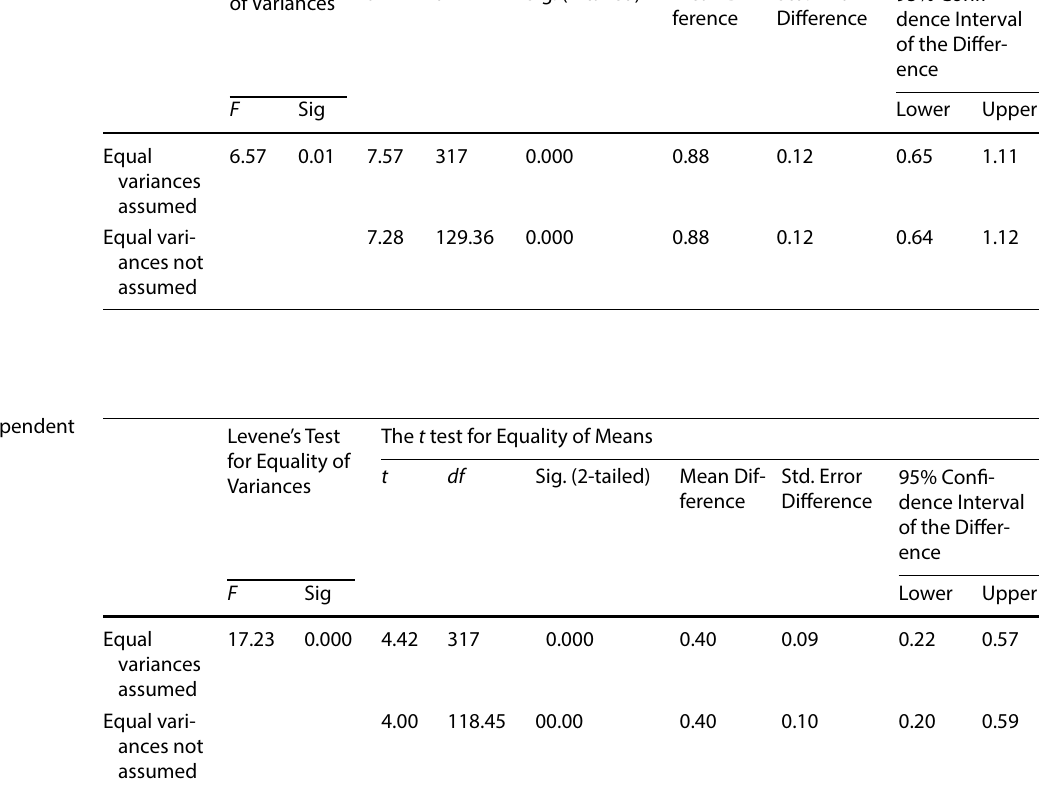
Levene’s Test t- test for Equality of Means for Equality of Variances